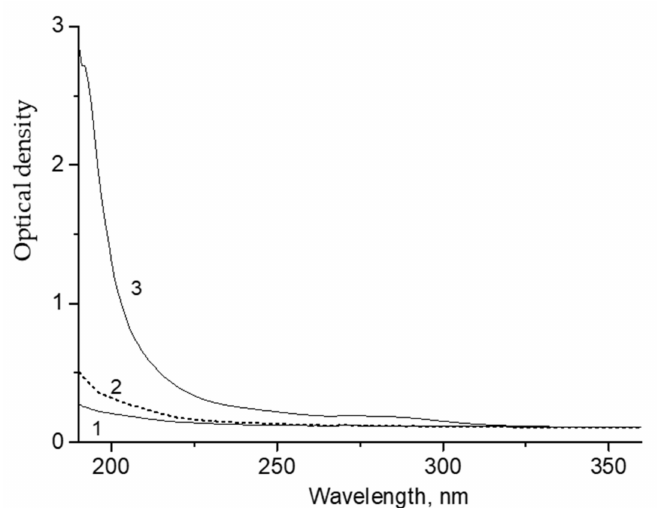
Figure 5. UV spectra of water ( 1 ), aqueous phase after extraction of initial decalin with water ( 2 ) and aqueous phase after extraction of decalin ozonated for 17 min ( 3 ). Optical path, 2 mm.